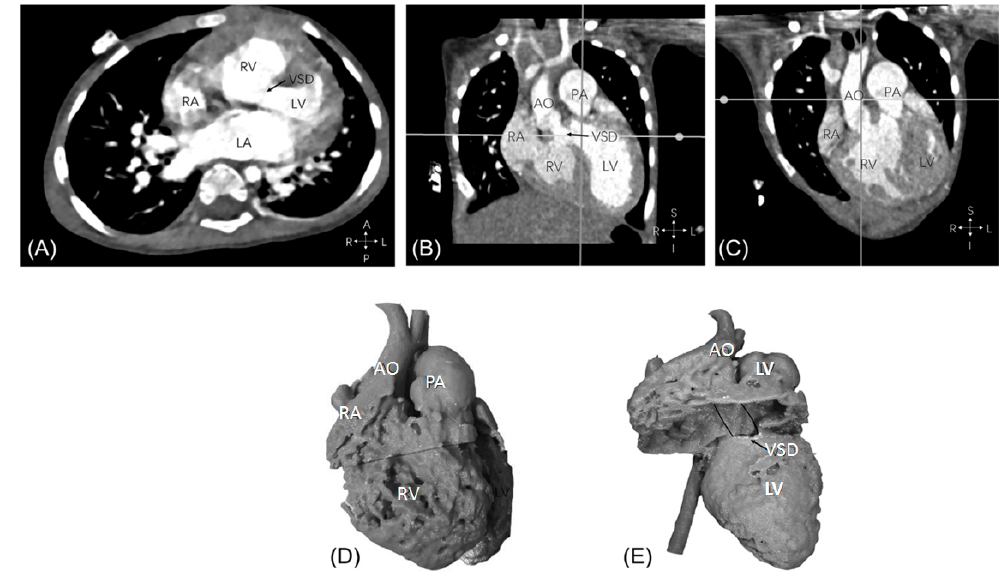
Figure 9. Comparison of low-cost (left image) with high-cost (right image) 3D printed heart model with similar accuracy in delineating cardiac anatomy and ventricular septal defect.